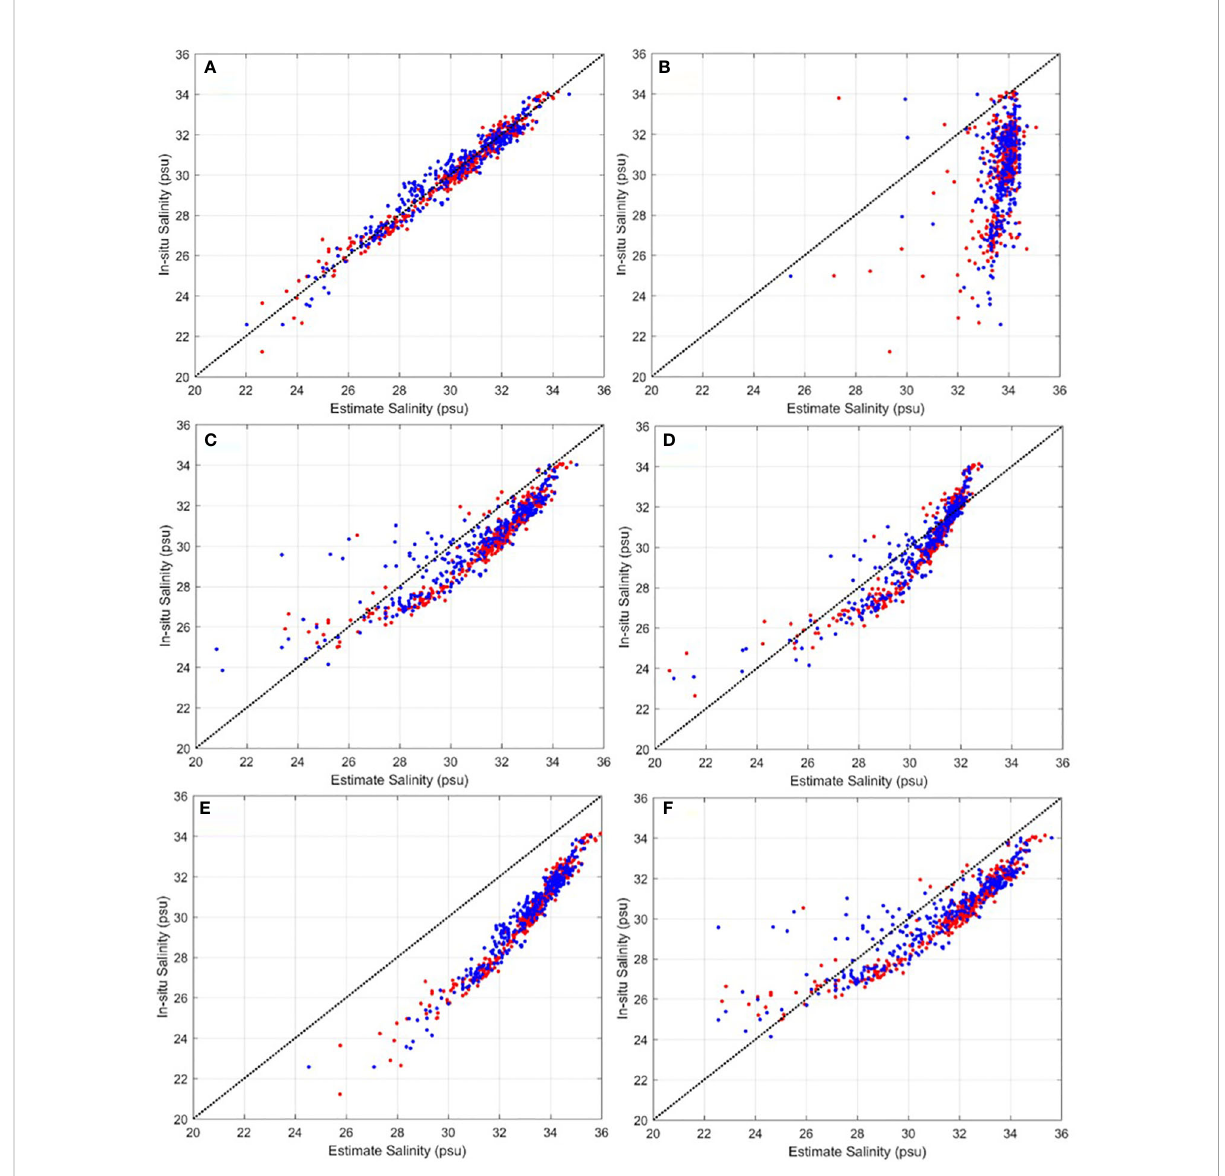
FIGURE 5 Comparison between in situ salinity and satellite-derived salinity estimated using (A) Eq. 4 and the methods of (B) Binding and Bowers (2003), (C) Ahn et al. (2008), (D) Sasaki et al. (2008), (E) Son et al. (2012), and (F) Bai et al. (2013). Red dots indicate the matched dataset (Figure 4); blue dots indicate the validation dataset, comprising data collected during NIFS and KIOST cruises (Figure